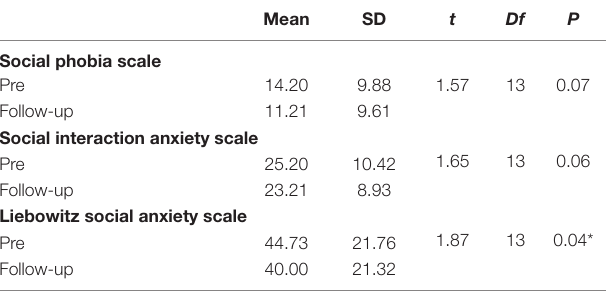
tABLe 1 | Means and sDs for social anxiety